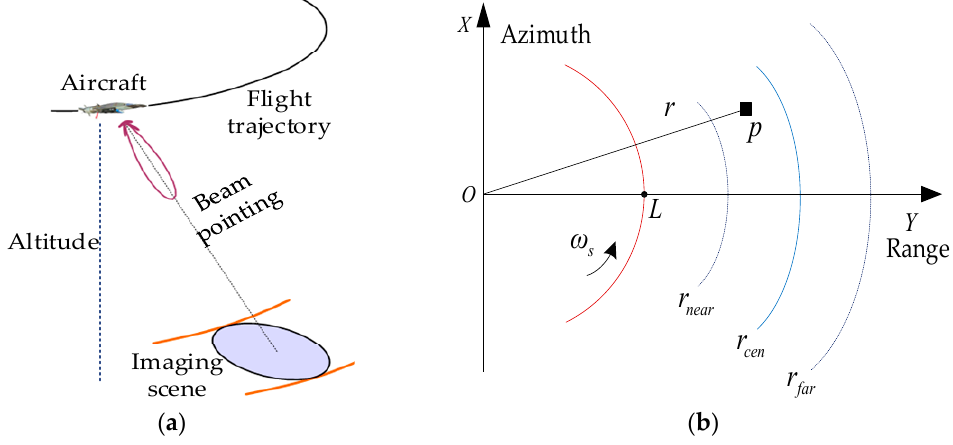
Figure 1. SAR imaging model for hypersonic platform: ( a ) geometric diagram; ( b ) plane diagram.